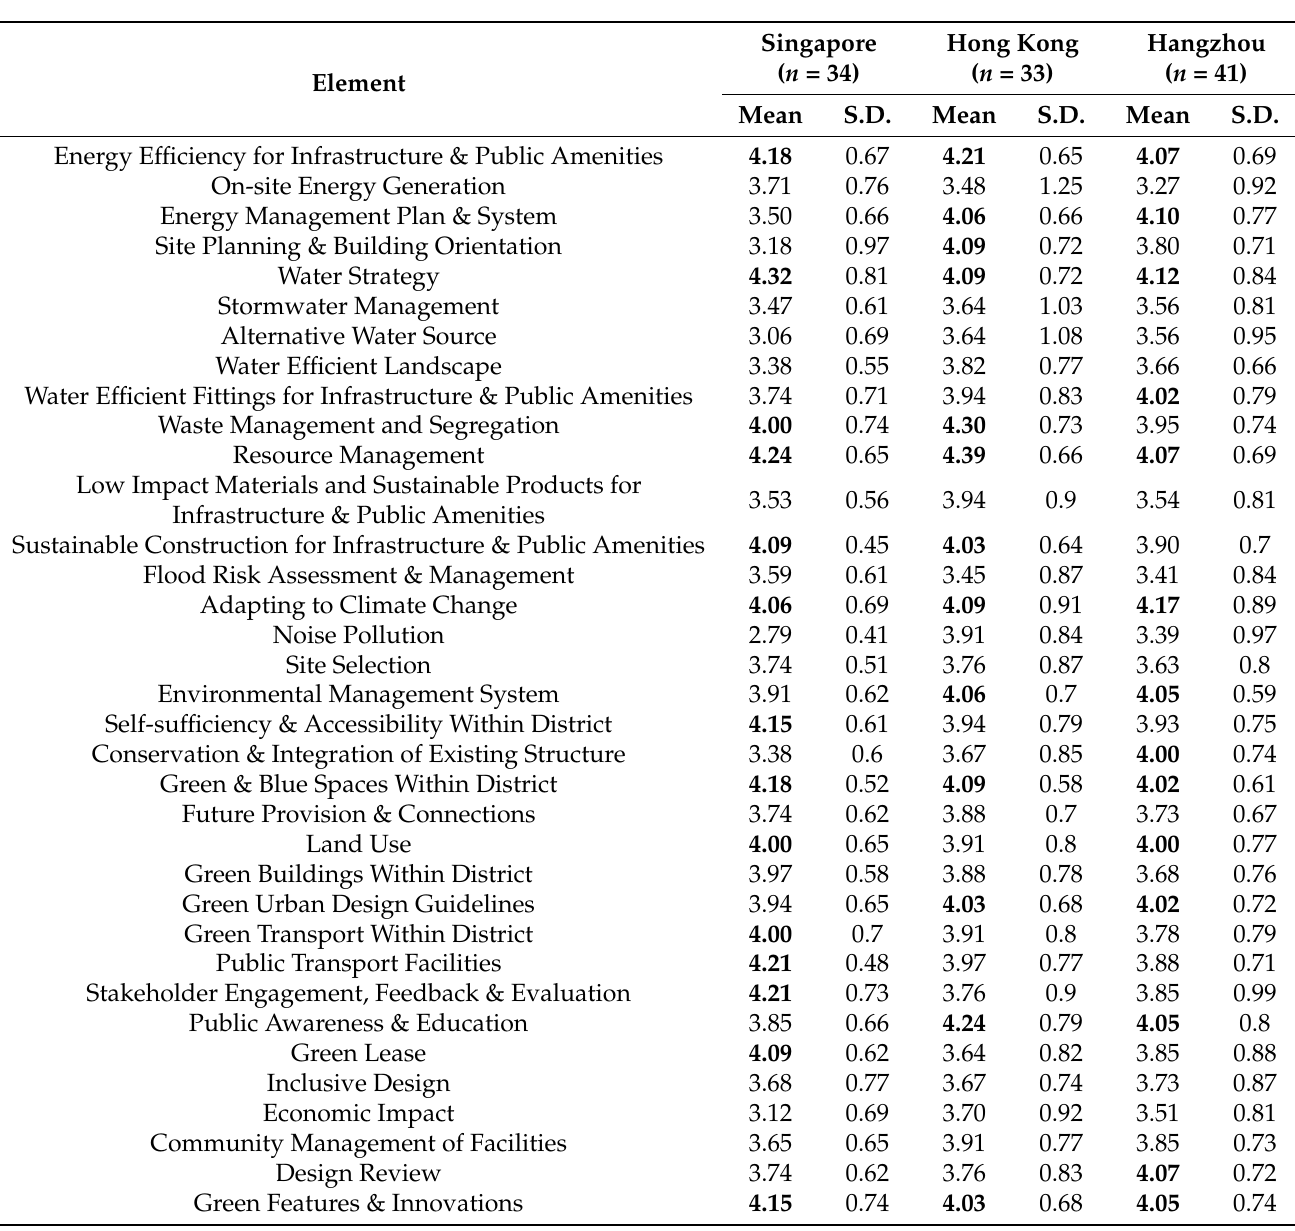
Table 6. The average significance level of preliminary indicators in Singapore, Hong Kong and